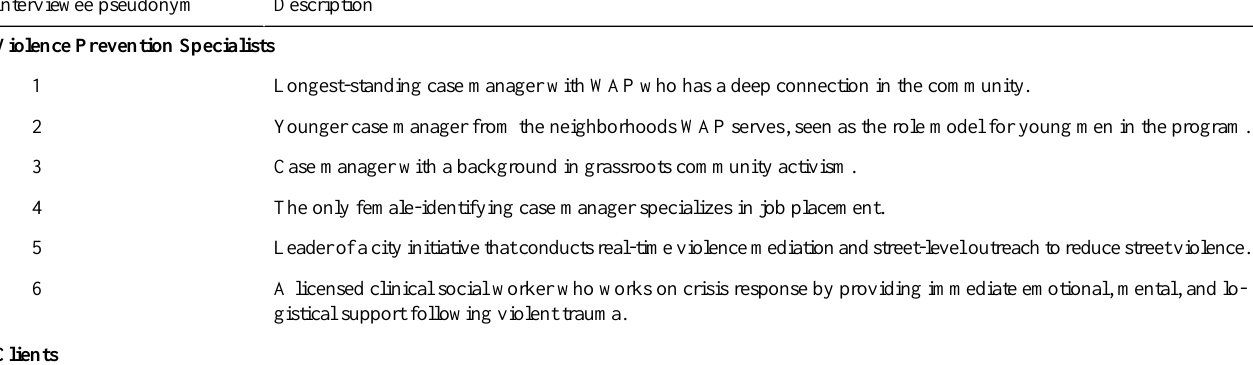
Table 1. Descriptions of Users. DescriptionInterviewee pseudonym Violence Prevention